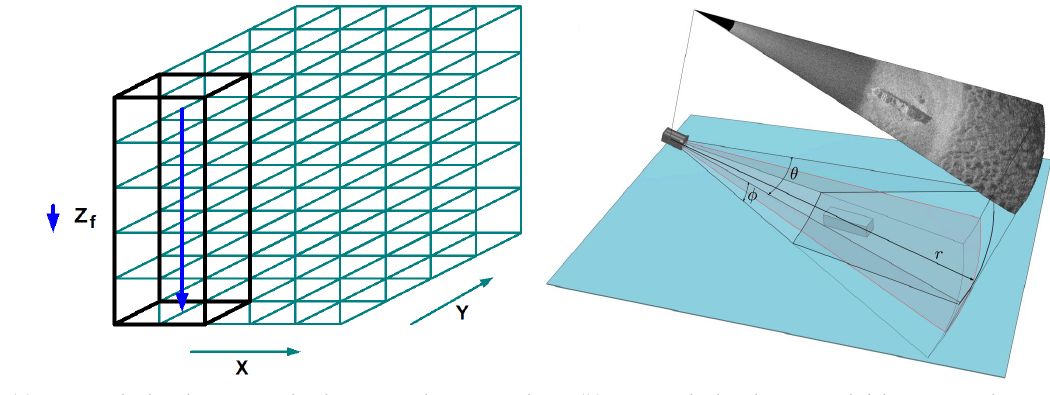
Figure 1. The image reconstruction is directly calculated on a Cartesian grid. A single beam S bf ( z f ) represents a perpendicular vector within the voxel-grid S bf ( x , y , z ) in contrast to the representation in spherical-coordinates with azimuth/elevation